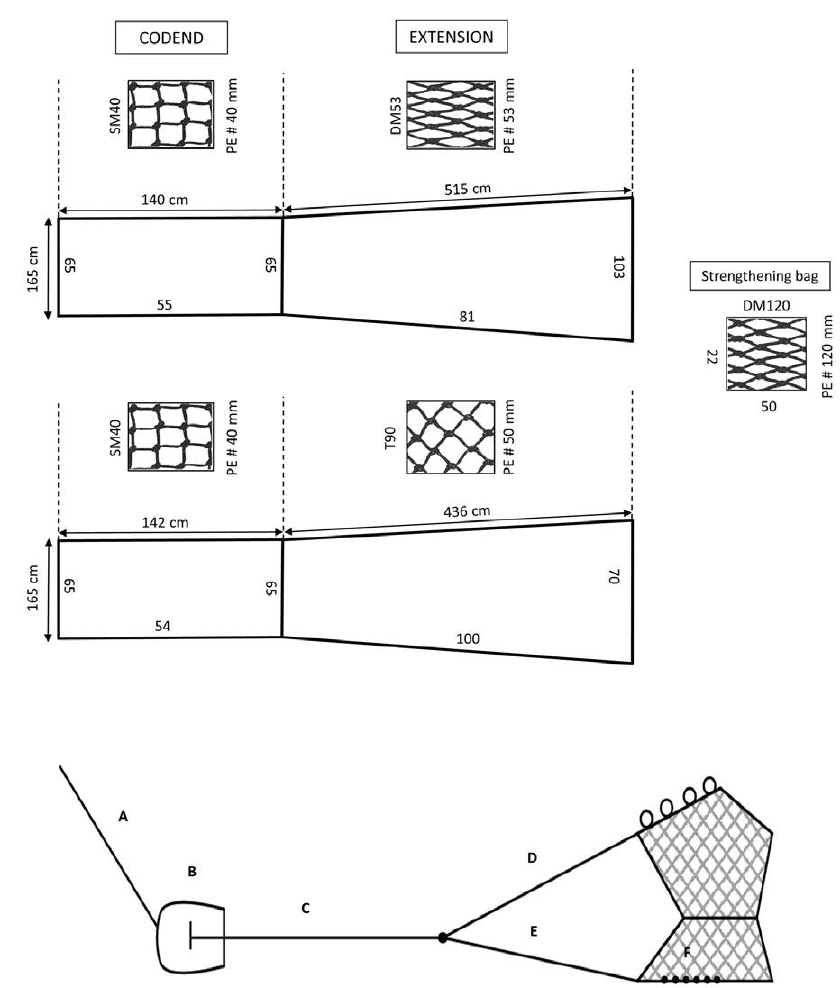
Fig. 2. – Characteristics of the trawl with details of the control and experimental aft parts of the net. In the lower panel: A, wire Ø16 mm, 265-330 m; B, trawl door (1250×770 mm), –110 kg; D, combinations rope Ø 22 mm, 220 m; E, wire Ø14 mm, 23 mm; F, chain, 3